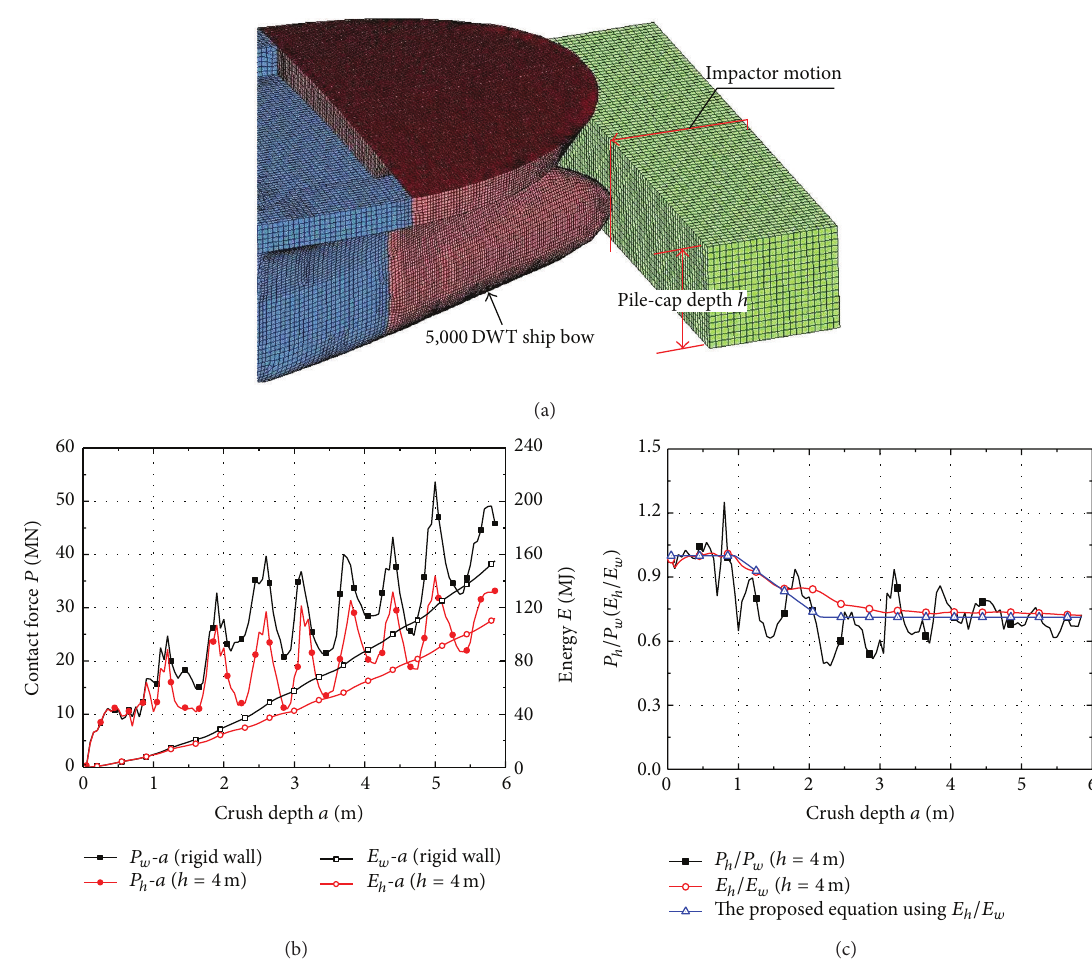
Figure 10: (a) 5,000 DWT crush model consisting of ship and pile cap; (b) P-a and E-a curves of rigid wall versus pile cap ( ℎ = 4 m, 5,000 DWT); (c) 𝑃 ℎ /𝑃 𝑤 versus 𝐸 ℎ /𝐸 𝑤 data (5,000